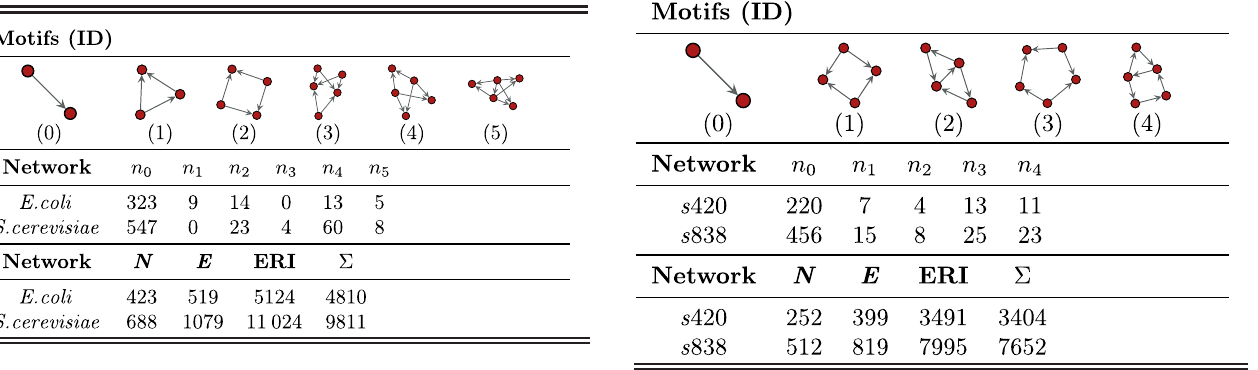
TABLE II. The network motifs of the transcription networks of E. coli and S. cerevisiae obtained using all biconnected motifs up to size 5.